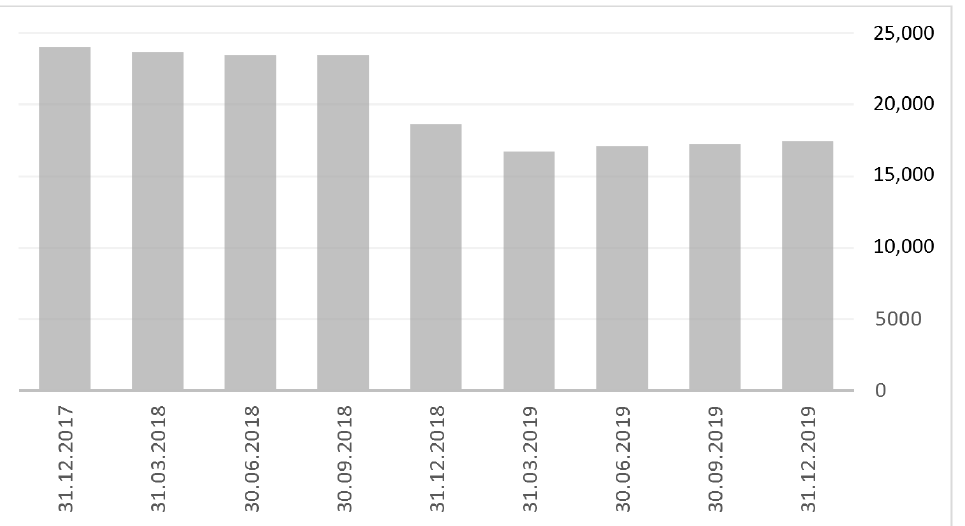
Figure 6. Registered tied agents for consumer credit other than for house purchase.